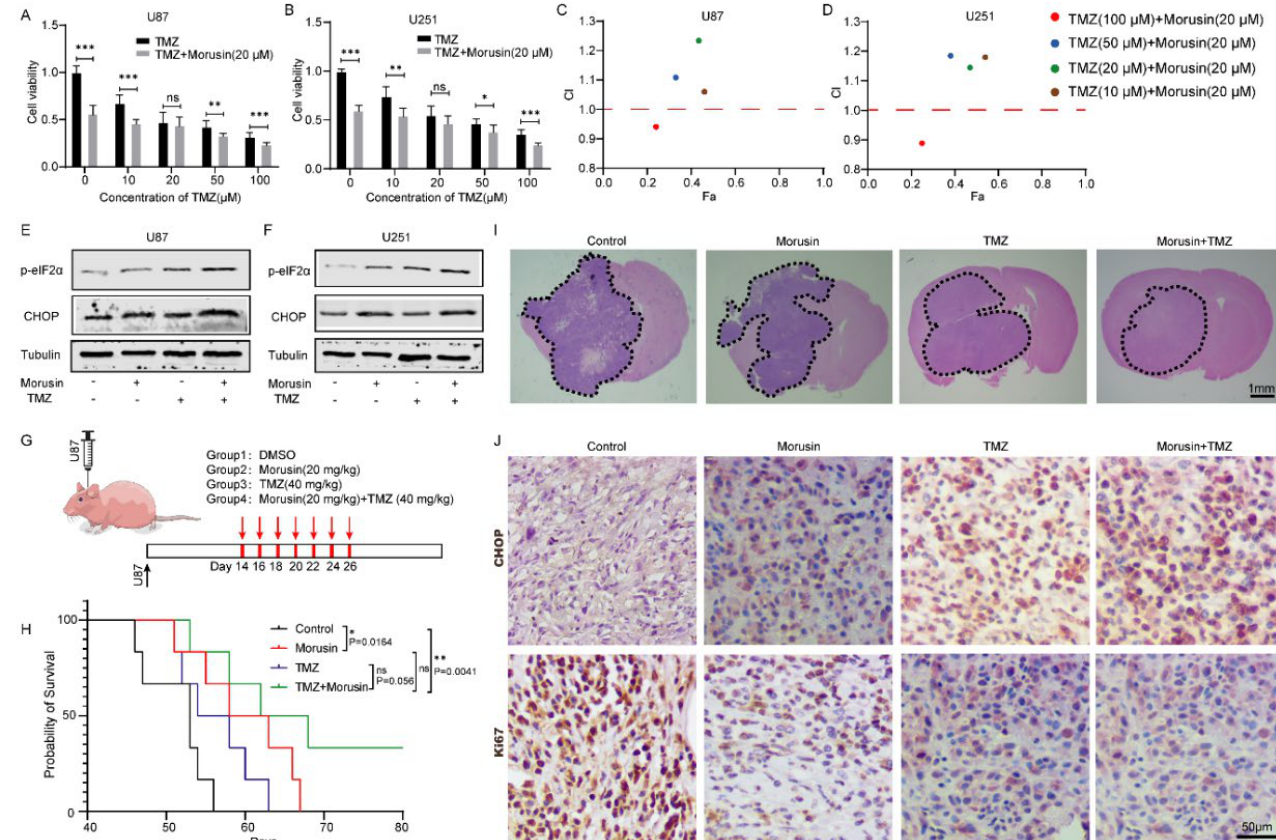
Figure 6. The synergistic anti-tumor effect of morusin and TMZ in GBM. ( A , B ) The viability of U87 and U251 cells treated with TMZ (0, 10, 20, 50, 100 µ M) combined with morusin (20 µ M) for 24 h. ( C , D ) Synergy was analyzed by CompuSyn software. CI = 1, >1 and <1 indicate additive, antagonistic and synergistic effects, respectively. ( E , F ) Levels of p-eIF2a and CHOP in GBM cells after morusin and TMZ exposure for 24 h. Tubulin was used as a loading control. n = 3. ( G ) A schematic of xenograft tumor experiment for the investigation of anti-tumor effects of morusin and TMZ in vivo. ( H ) The Kaplan–Meier survival curves of tumor bearing mice after treatment. ( I ) H&E-stained images of mouse brain sections. Scale bar = 1 mm. ( J ) Representative images of IHC analysis of CHOP and Ki-67 in the intracranial tumors after morusin and TMZ treatment. Immunoreactivity was detected by DAB chromogen (brown). The figures are representative data from at least three independent experiments. Scale bar = 50 µ m. * p < 0.05, ** p < 0.01, *** p < 0.0001 compared to indicated